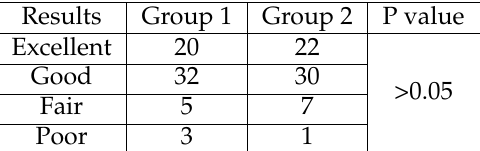
Table 3. Reich and Rosenberg